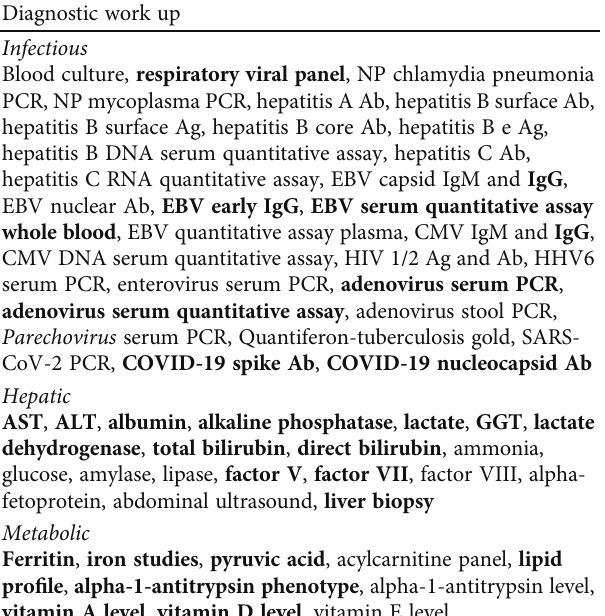
Table 1: Diagnostic work